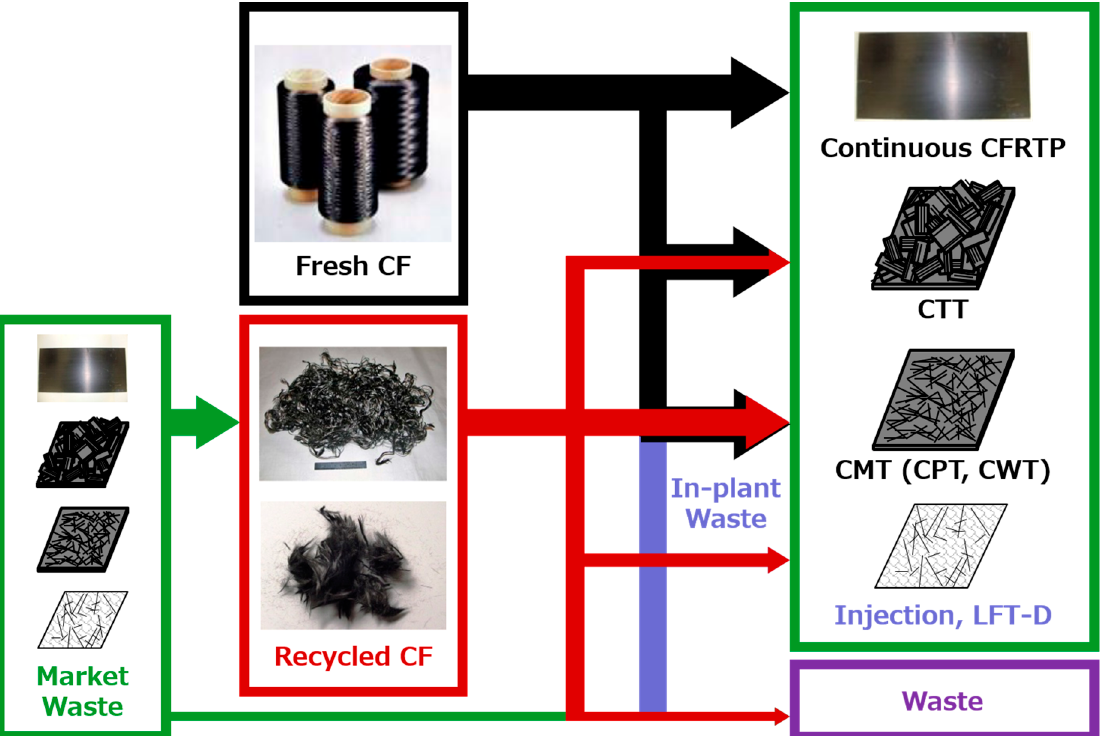
Figure 6. Intermediate materials and material flow developed in Japan’s CFRTP projects: chopped carbon fiber tape-reinforced thermoplastics (CTTs), carbon fiber mat-reinforced thermoplastics (CMTs), carbon fiber paper-reinforced thermo- plastics (CPTs), and carbon fiber card web-reinforced thermoplastics (CWTs).